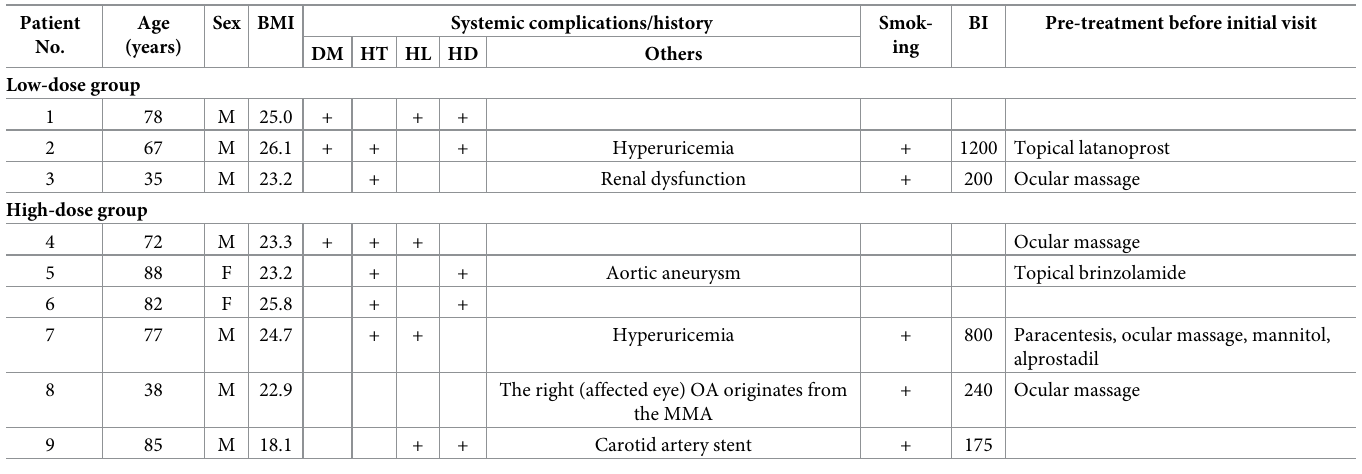
Table 1. Baseline characteristics of systemic condition of patients. Patient No.